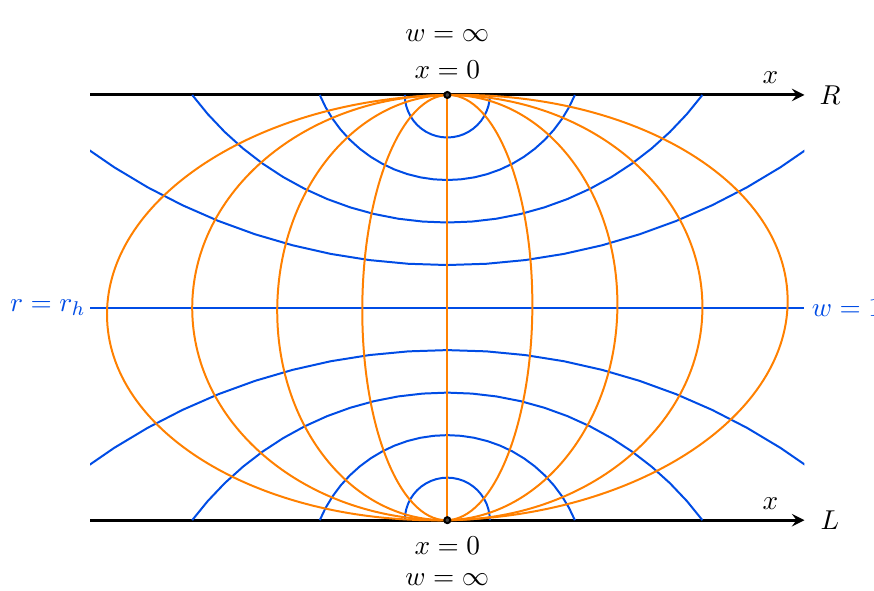
Figure 4 . Picture representing an AdS slice of the BTZ black hole at constant time. The lines at constant w are depicted in blue, while the curves at constant µ in orange. The coordinate x runs along the left ( L ) and right ( R ) disconnected boundaries. The coordinate r covers the region outside the horizon and runs on the vertical axis: starting from the middle line located at r = r it increases towards the L and R